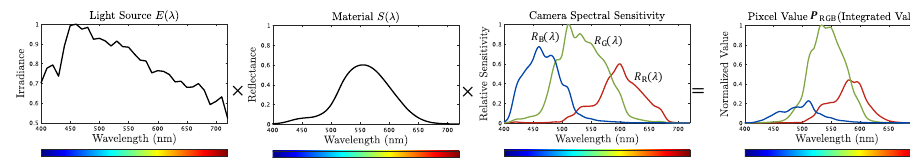
Figure 1. Imaging pipeline of RGB digital